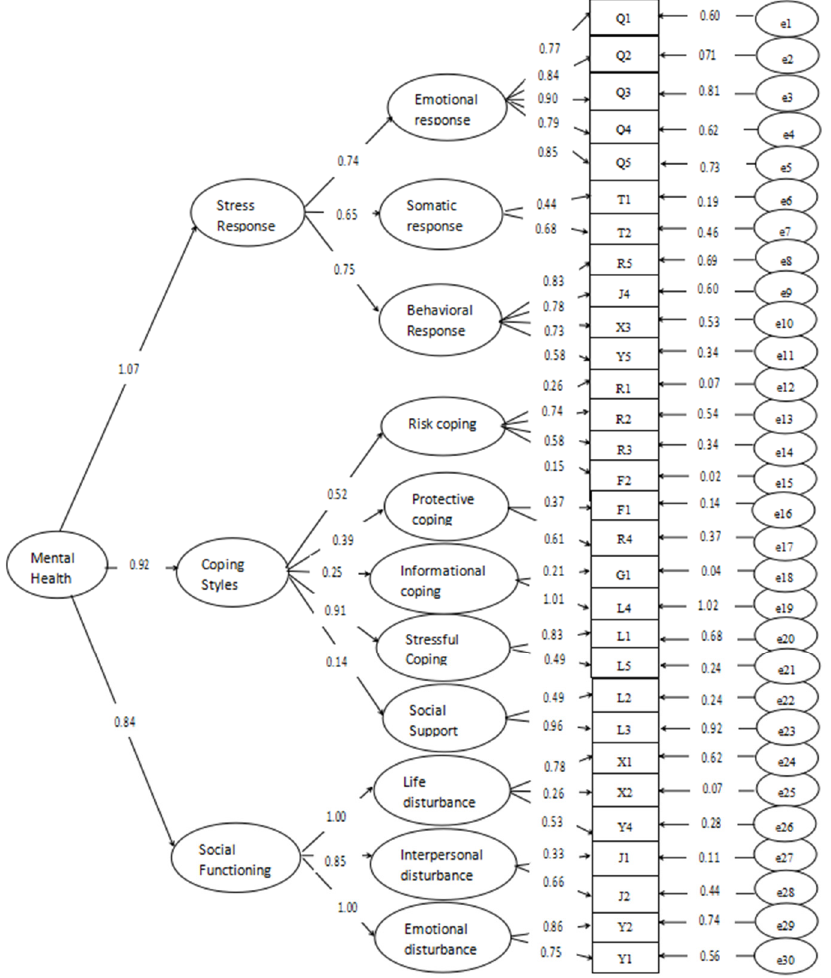
Figure 1. Confirmatory factor analysis of model of college students’ mental health during the pandemic.